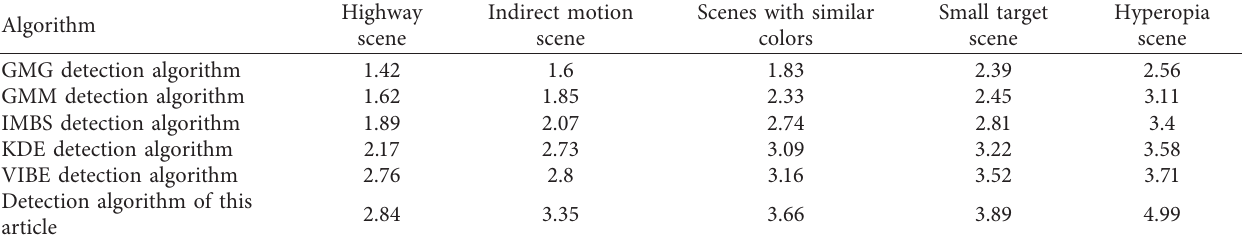
Table 2: Baseline video library scene effect analysis data.